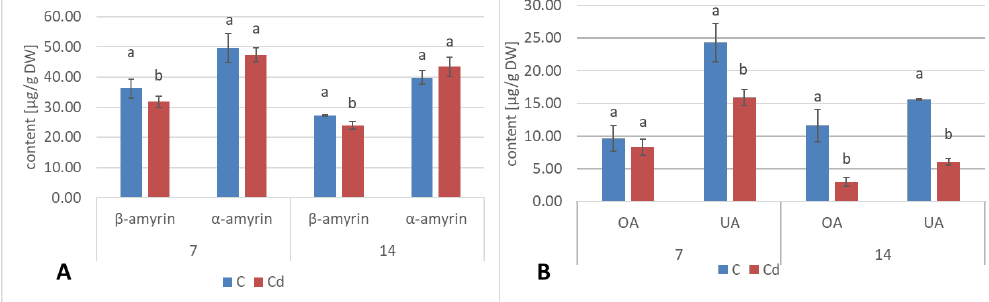
Figure 24. The content of neutral triterpenoids ( A ) and triterpenoid acids ( B ) in C. officinalis shoots. OA—oleanolic acid, UA—ursolic acid. Bars which do not share a common letter are significantly different ( p < 0.05).